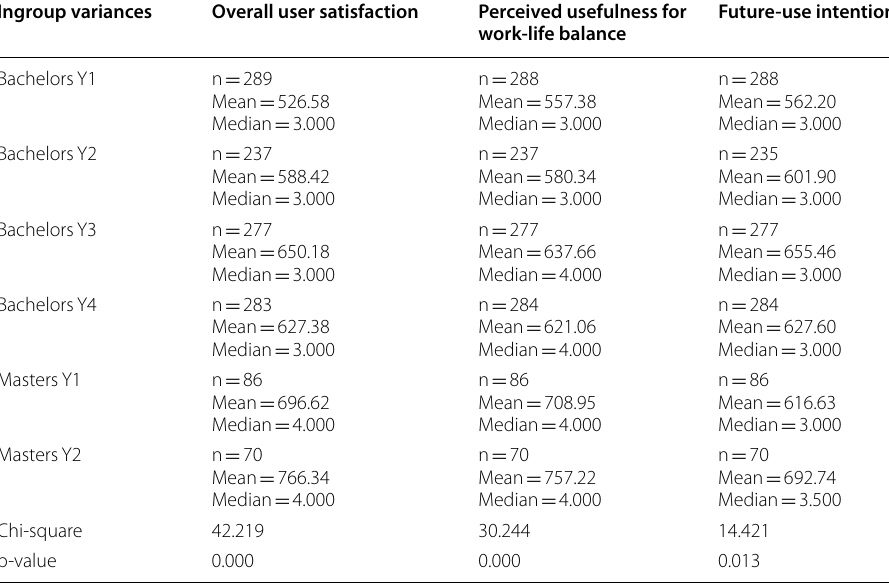
Table 6 Kruskal–Wallis H test results Ingroup variances Overall user satisfaction Perceived usefulness for